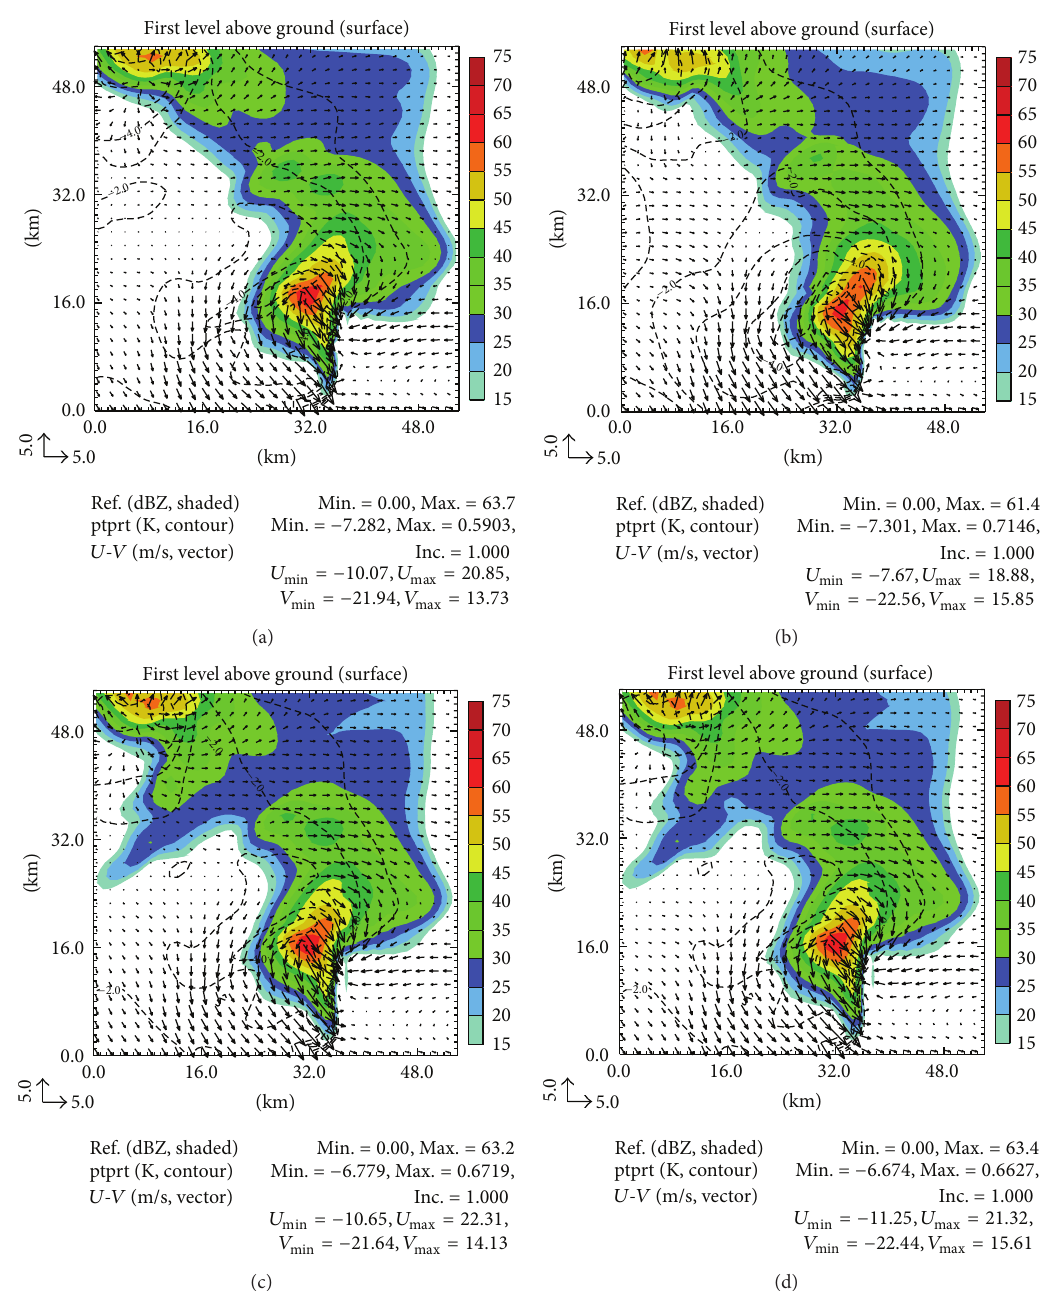
Figure 3: Horizontal winds (vectors; ms −1 ), perturbation potential temperature (contours at 1-K intervals), and simulated reflectivity (shaded contours; dBZ) at 250 mAGL for (a) the truth simulation; (b) the 3DVAR analysis; (c) the EnKF analysis; and (d) the hybrid EnKF-3DVAR analysis for the single radar experiment. The time shown is at 100 min (the end of data assimilation cycles). Wind vectors are shown every 2 km. is the reflectivity field in the center of model domain. The area of reflectivity values greater than 55 dBZ is over extended in a peanut-shaped region for 3DVAR. The spread of potential temperature is little bit far to the south-southwest direction in the southwest corner (Figure 3(b)). But the strength of the cold pool in 3DVAR, as indicated by minimum perturbation potential of − 7.30 ∘ , is closer to the truth simulation ( − 7.28 ∘ ) than seen in either EnKF or the hybrid EnKF-3DVAR.